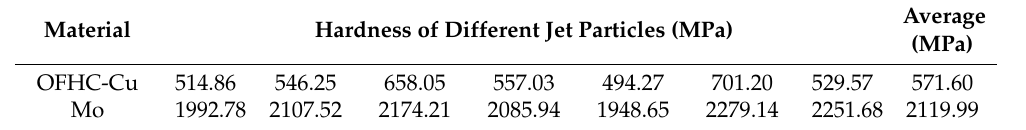
Figure 11. Recovered jet fragments and slugs. ( a ) OFHC-Cu; ( b ) Mo. Seven recovered fragments of each of the OFHC-Cu and Mo jets were selected and analyzed using a hardness tester to determine their hardness. The results were averaged to yield the average hardness for each jet. As shown in Table 5, the recovered OFHC-Cu and Mo jet samples exhibited the average hardness of 571.61 and 2119.99 MPa, respectively. The hardness of the Mo jet fragments was approximately 3.7 times that of the OFHC-Cu jet fragments. Table 5. Hardness of the